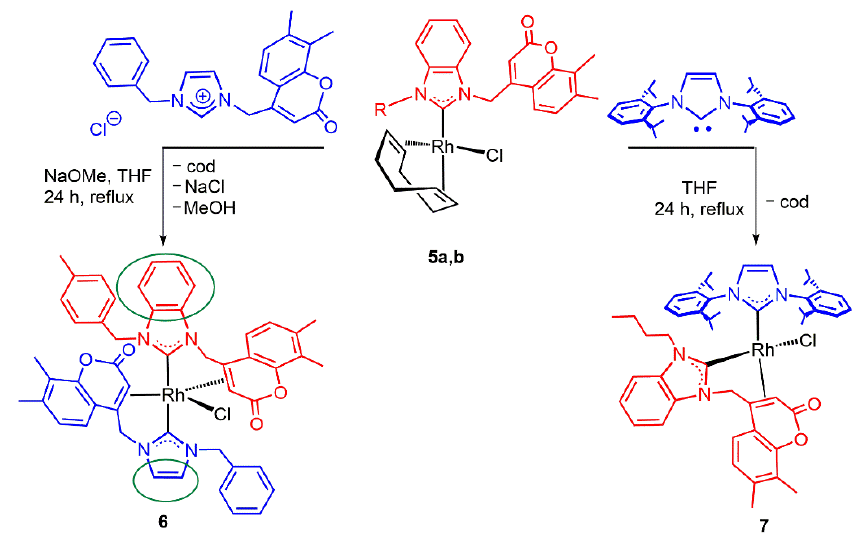
Scheme 3. Preparation of coumarin-functionalized mixed bis-NHC rhodium complexes.